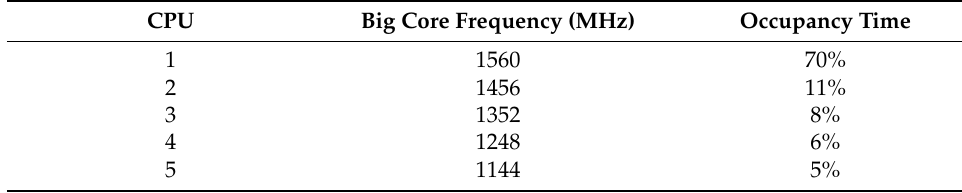
Table 5. CPU big core frequency share.